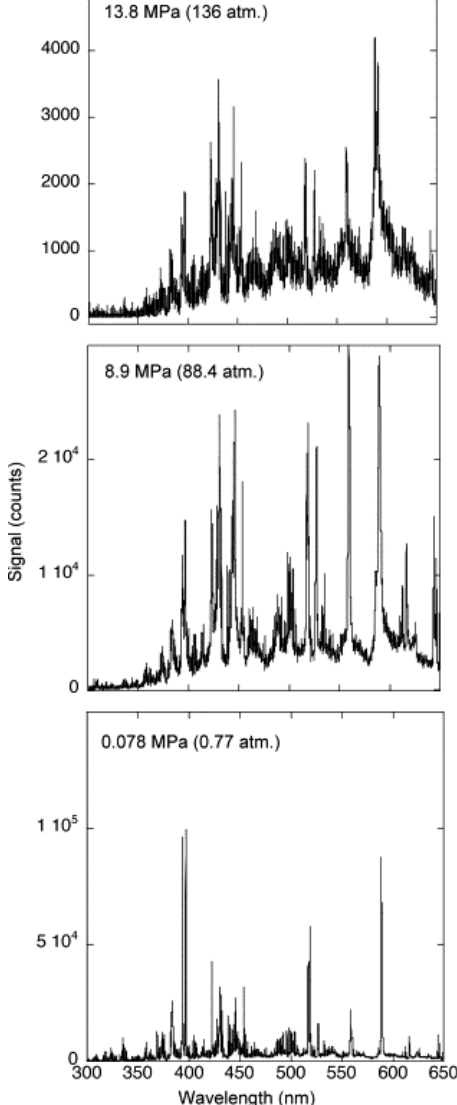
Figure 6. LIBS spectra of basalt taken in 0.77, 88.4 and 136 atm. Reprinted from reference